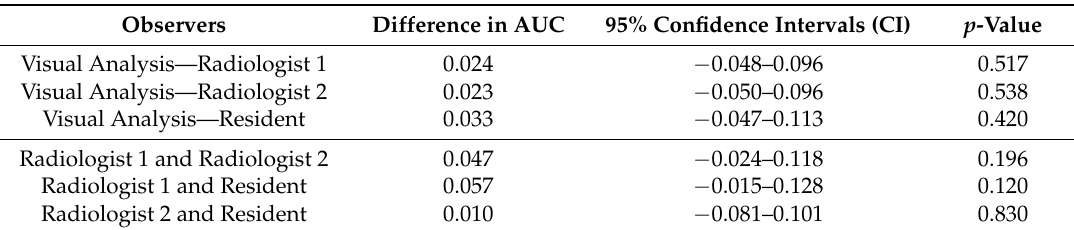
Table 6. Classification based on automatic